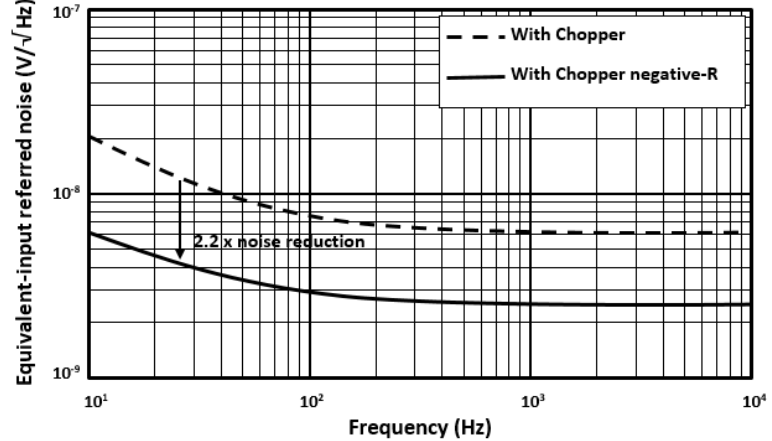
Figure 7. Equivalent-input referred noise of the proposed chopper negative-R stabilization preamplifier.